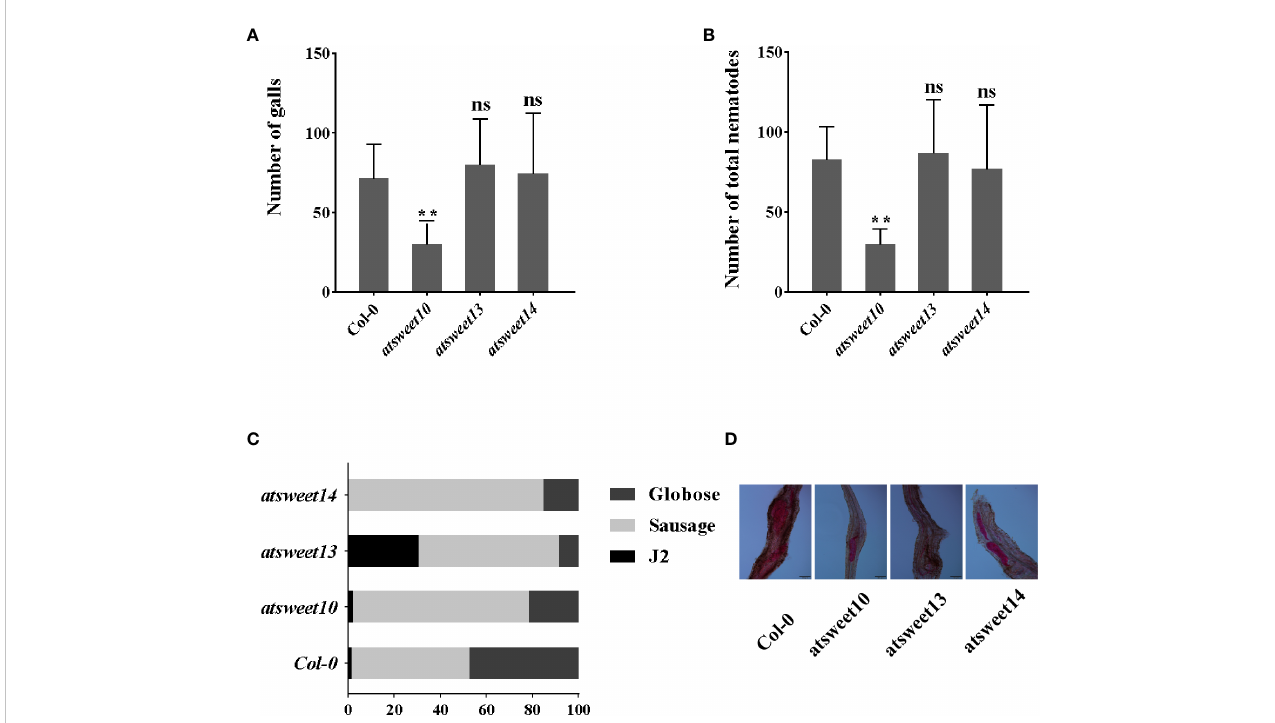
FIGURE 5 Response of A. thaliana mutants and wild-type Col-0 plants to M. incognita infection. (A) The number of galls in the root of Arabidopsis inoculated with M. incognita at 18 dpi. (B) The total number of nematode-infected Arabidopsis . (C) Percentage of nematodes corresponding to different developmental stages (J2 stage; Sausage stage; Globose stage) in the mutants and wild-type Col-0 at 18 dpi (n = 15). (D) The major developmental morphology of nematodes in Col-0, atsweet10 , atsweet13 , and atsweet14 mutants at 18 dpi. Data are presented as mean ± SD, and p-values were analyzed using student ’ s t-test (p**<0.01). ns, no signi fi cant difference. Scale bars=100 m